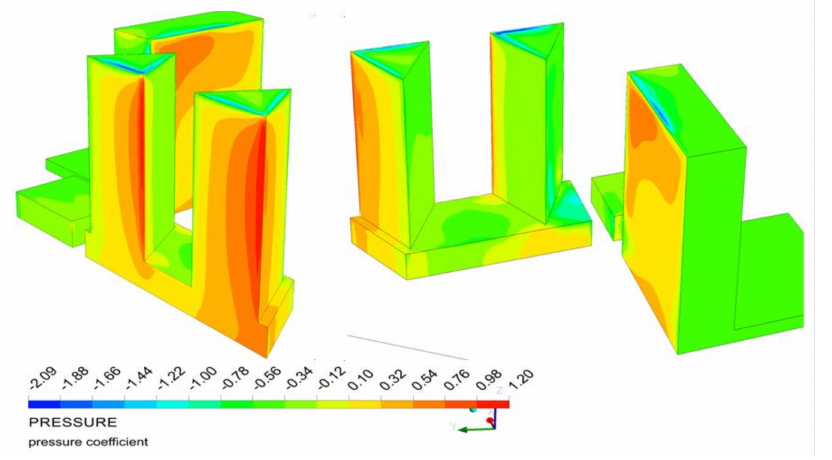
Figure 21. Contours of dimensionless pressure coefficient Cp [ − ] for two